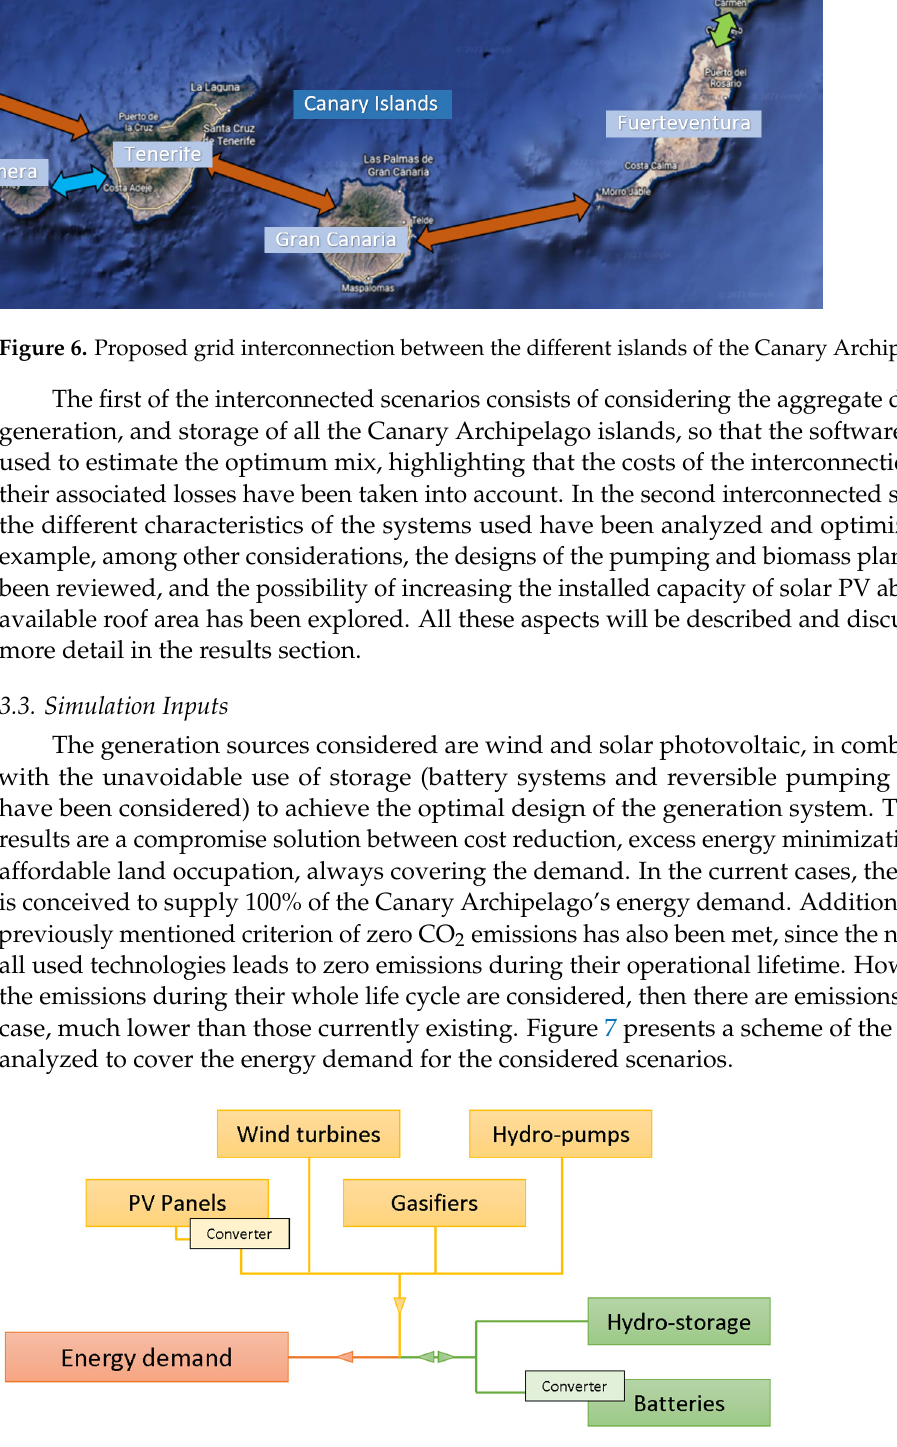
Figure 7. Scheme of the energy demand scenarios and the analyzed energy sources.